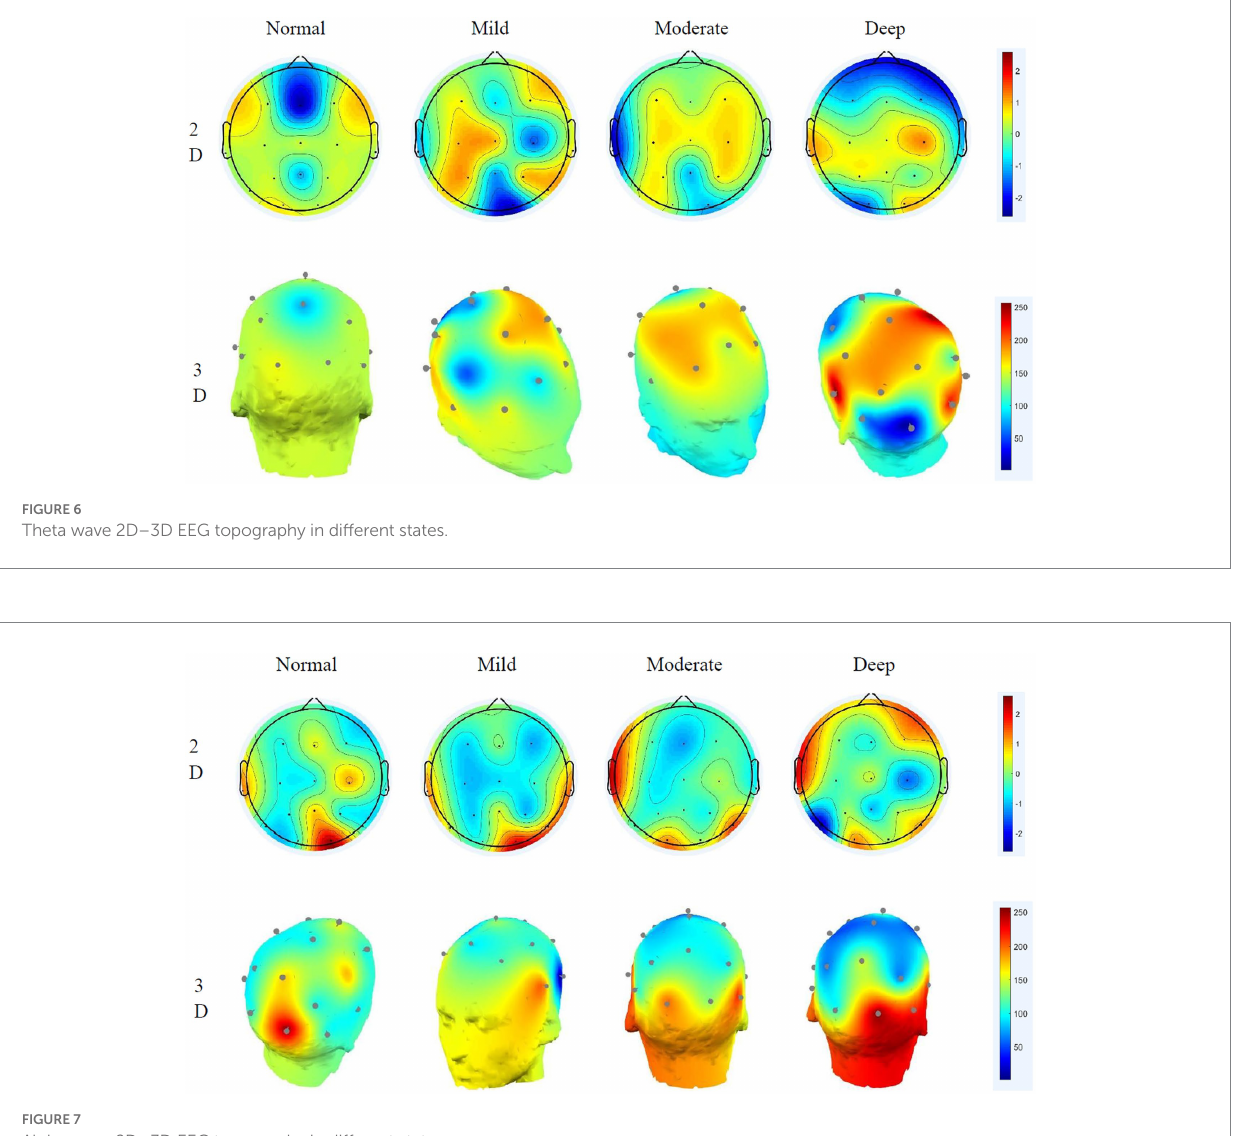
FIGURE 7 Alpha wave 2D–3D EEG topography in different states.